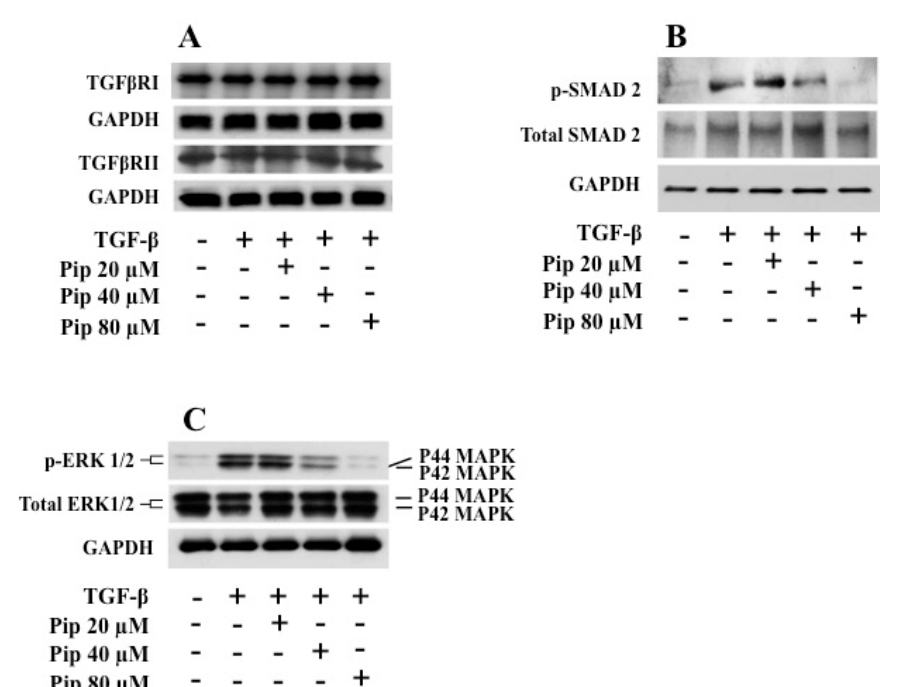
Figure 7. Effect of piperine on TGF- β receptors (TGF β RI and TGF β RII) and ERK 1/2 and SMAD2 activation in A549 cells treated with TGF- β 1. A549 cells were plated in serum free medium and pretreated with 20, 40 and 80 µM piperine for 24 h. After treatment, cells were or not stimulated with 1 ng/mL recombinant human TGF β 1. The cells were then collected, washed with PBS and lysed in RIPA buffer. Western blot analysis was employed to evaluate ( A ) the expression of TGF β RI and TGF β RII receptors, ( B ) phospho-SMAD2 and ( C ) phospho-p44/42 MAPK (ERK1/2).